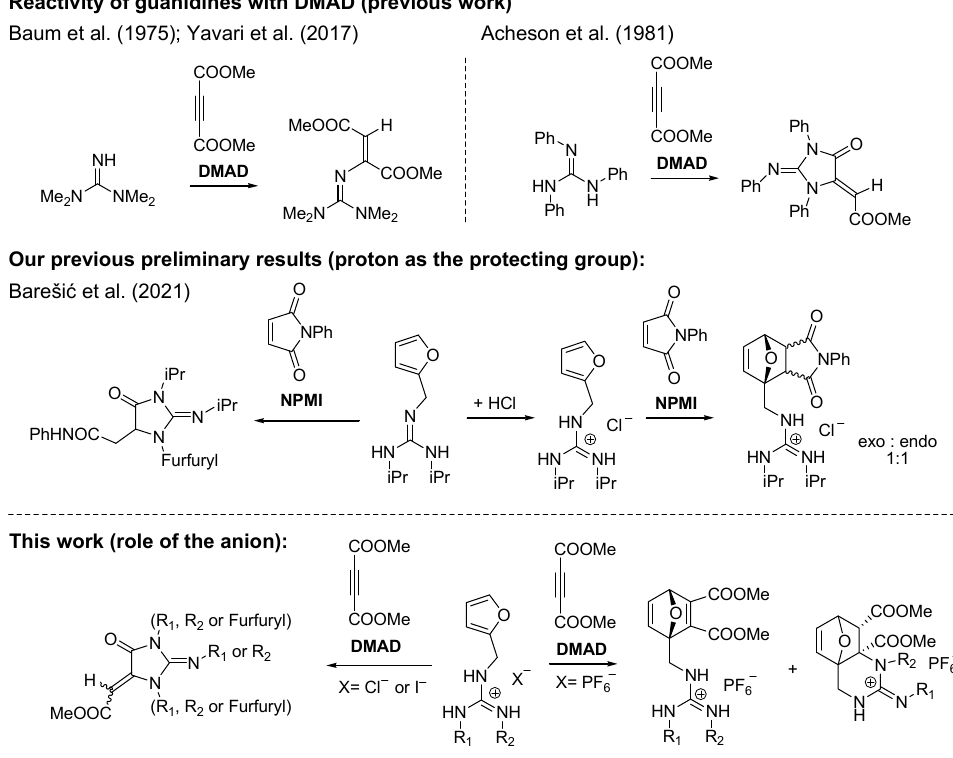
Figure 1. Typical reactivity of guanidines and their salts with typical dienophiles DMAD and NPMI [16,18,19,24].